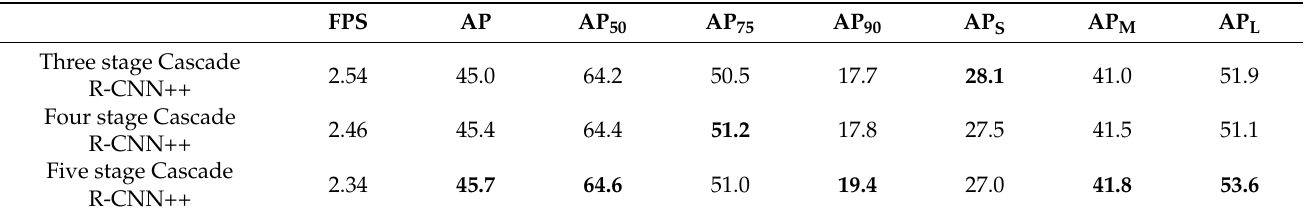
Table 2. Performance comparison between three-, four-, and five-stage implementations of